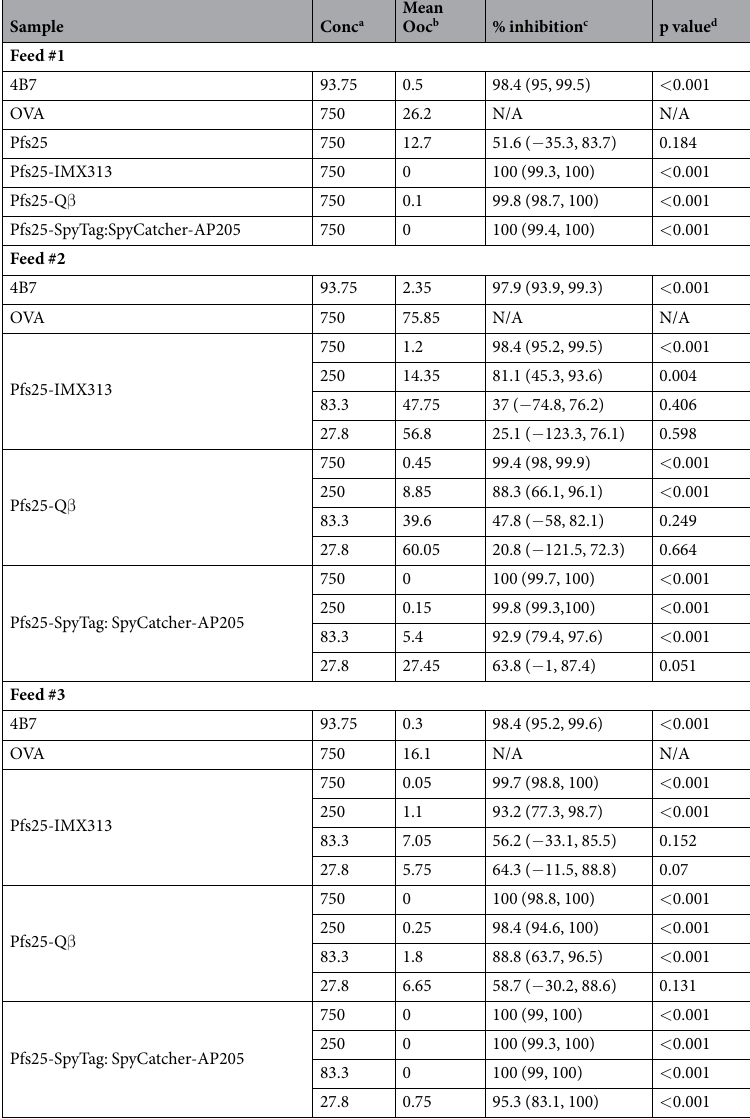
Table 2. Transmission reducing activity of IgG from immunised mice. a IgG concentration ( μ g/ml) in feeder. b Arithmetic mean of oocyst intensity from 20 mosquitoes. c Percent inhibition of mean oocyst intensity and the 95% confidence interval (95% CI). d Two-sided p values testing whether % inhibition is significantly different from